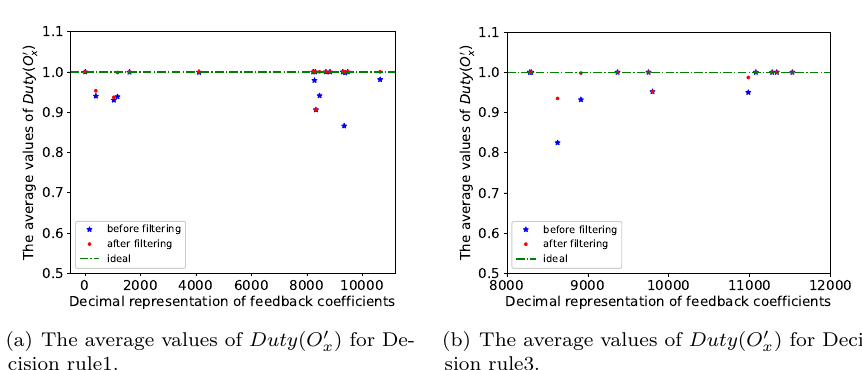
Figure 19: The verification for Decision rule1 and Decision rule3 with measured data.